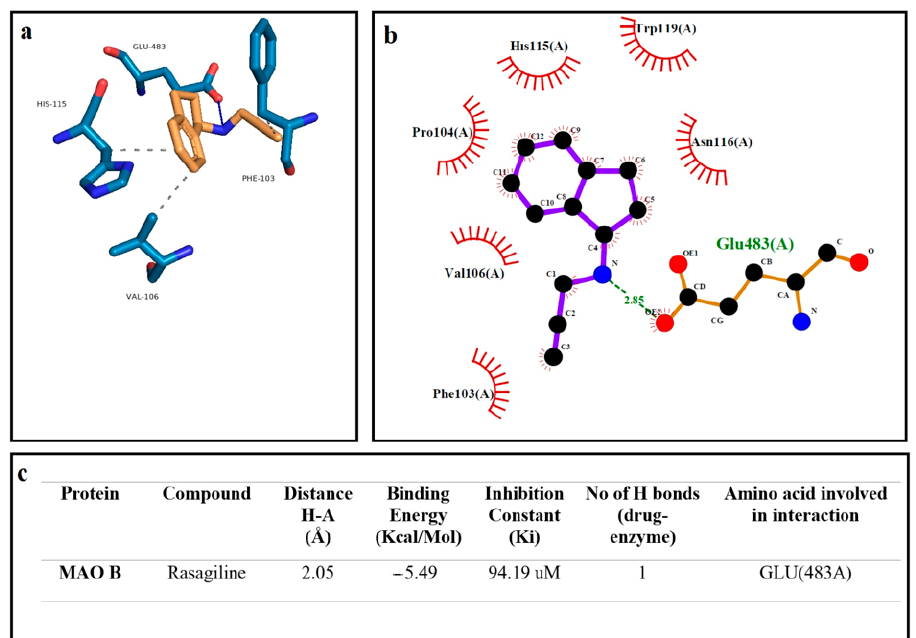
Figure 4. The best docking formation of the binding mode of Human Monoamine Oxidase B (Mao B-2BK5) with rasagiline obtained by ( a )—PyMol, ( b )—LigPlot, and ( c )—the table of Hydrogen- bonds (H-bonds) (with distance Å), binding energy (Kcal/mol), inhibition constant, number of H-bonds (drug-enzyme) and amino acid involved in interaction obtained from the Protein-Ligand Interaction Profiler. The blue line and dashed gray show the H-bonds and Hydrophobic Interaction in Pymol,